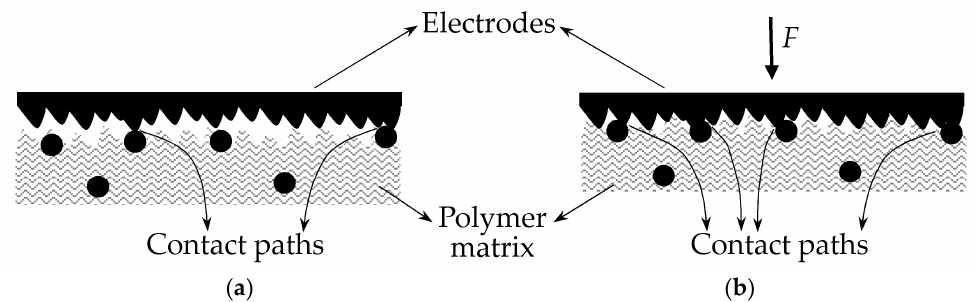
Figure 6. Schematic view at a microscopic scale of the contact paths at different loading conditions. Conductive particles are represented as black points. ( a ) Paths at sensor rest, F = 0 ; ( b ) Paths during loading condition F > 0.